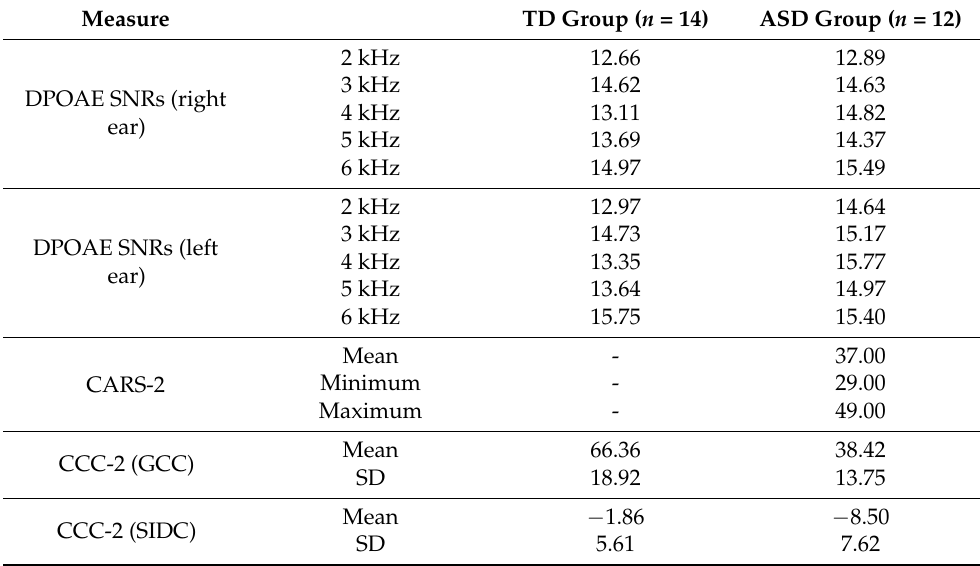
Table 1. DPOAE (dB), CARS-2, and CCC-2 results from TD and ASD